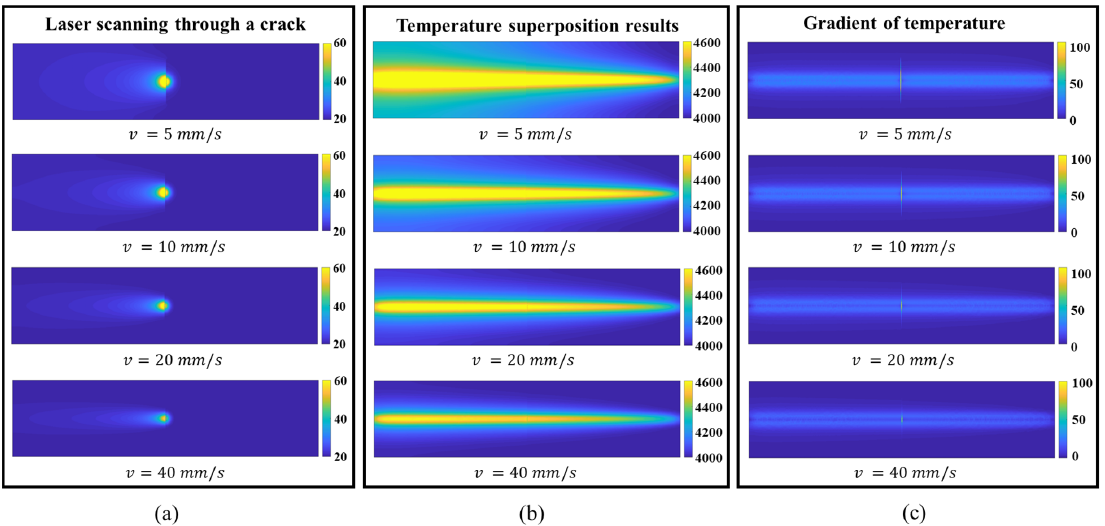
Figure 9. Crack detection at different laser scanning speed ( P = 1800 mW, f = 50 Hz): ( a ) temperature field of laser scanning through the crack; ( b ) superposition results of ∆ T ; ( c ) temperature gradient field ( T G ≥ 0